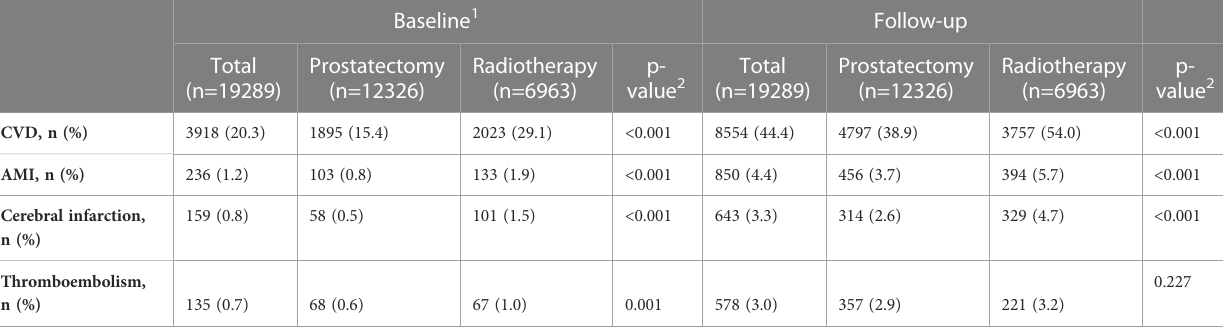
TABLE 2 Cardiovascular disease before diagnosis of prostate cancer (baseline) and after treatment with prostatectomy or